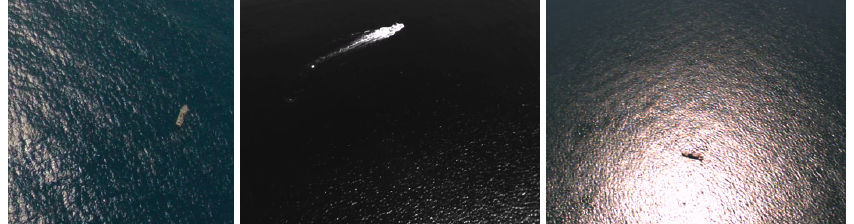
Figure 1. Example of airborne maritime surveillance images taken from the Seagull dataset [4].